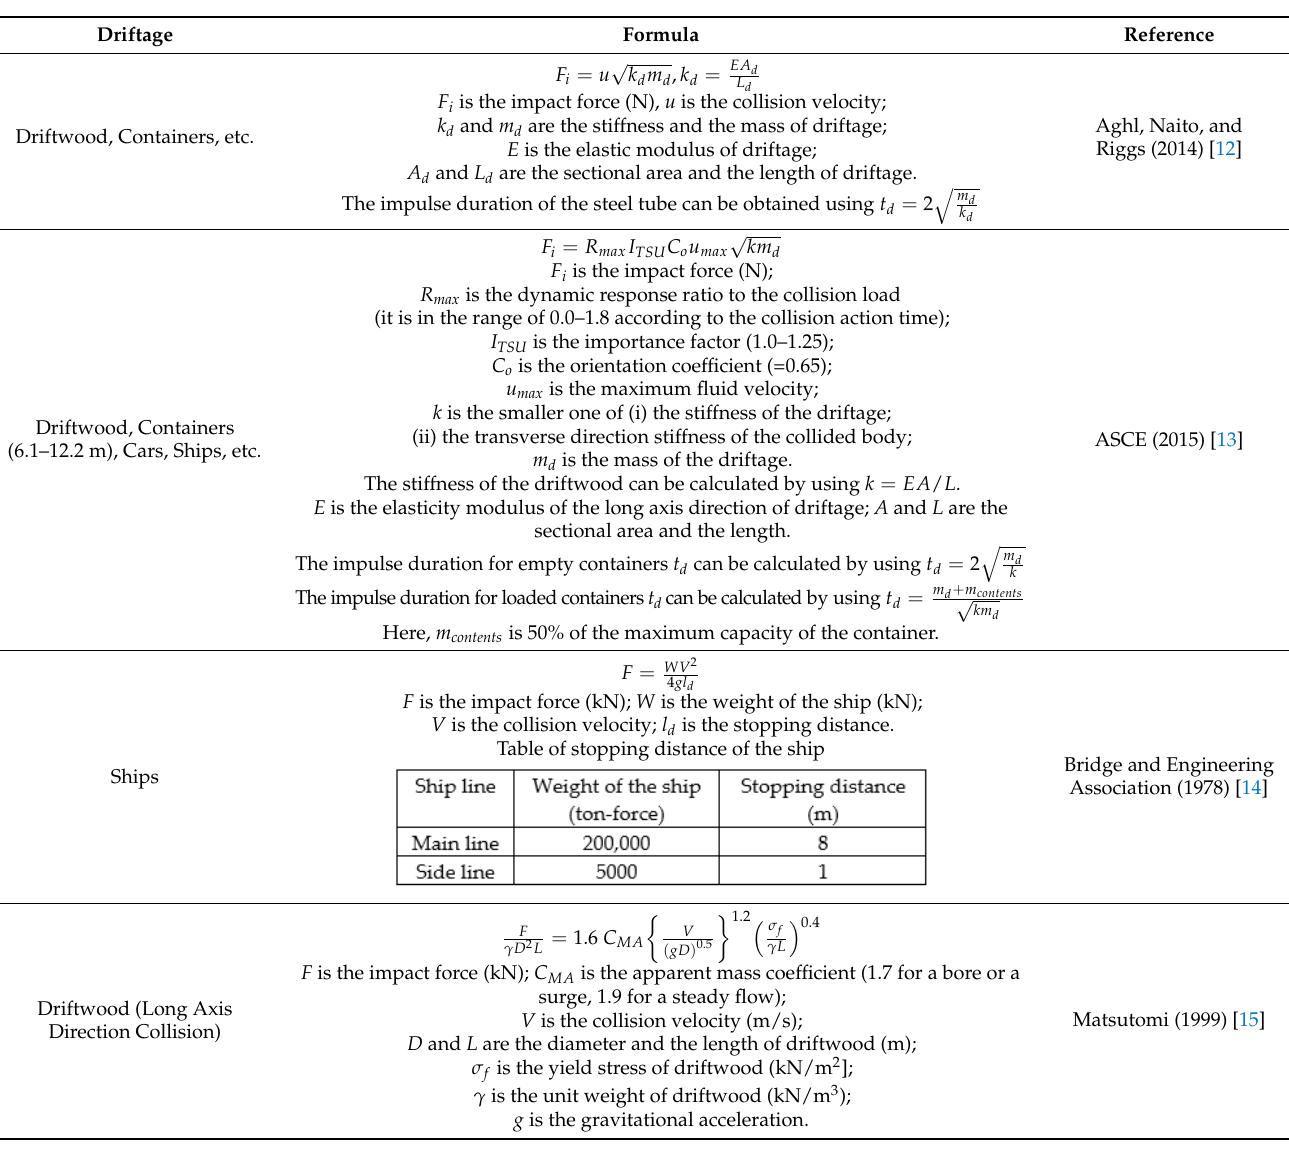
Table 2. Impact force formula (no. 2).